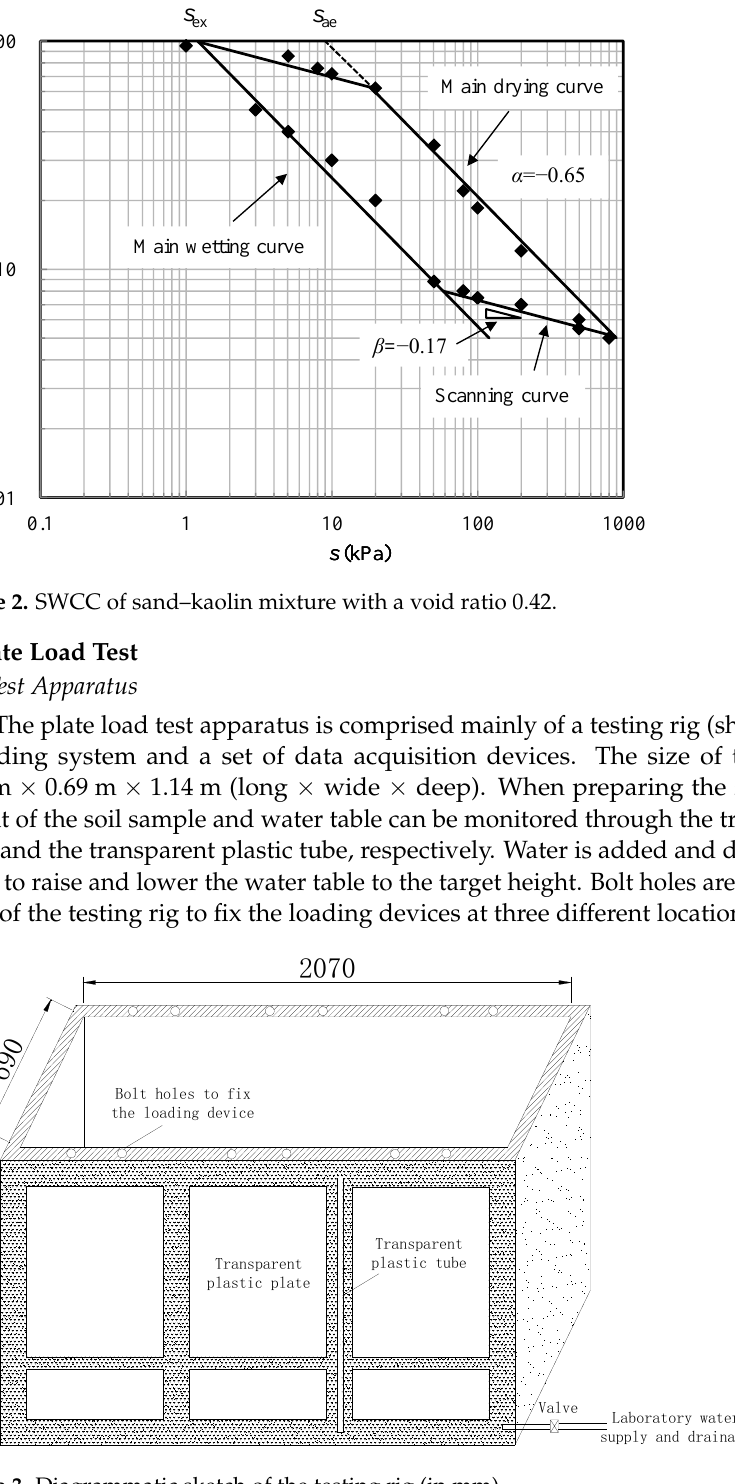
Figure 3. Diagrammatic sketch of the testing rig (in mm).